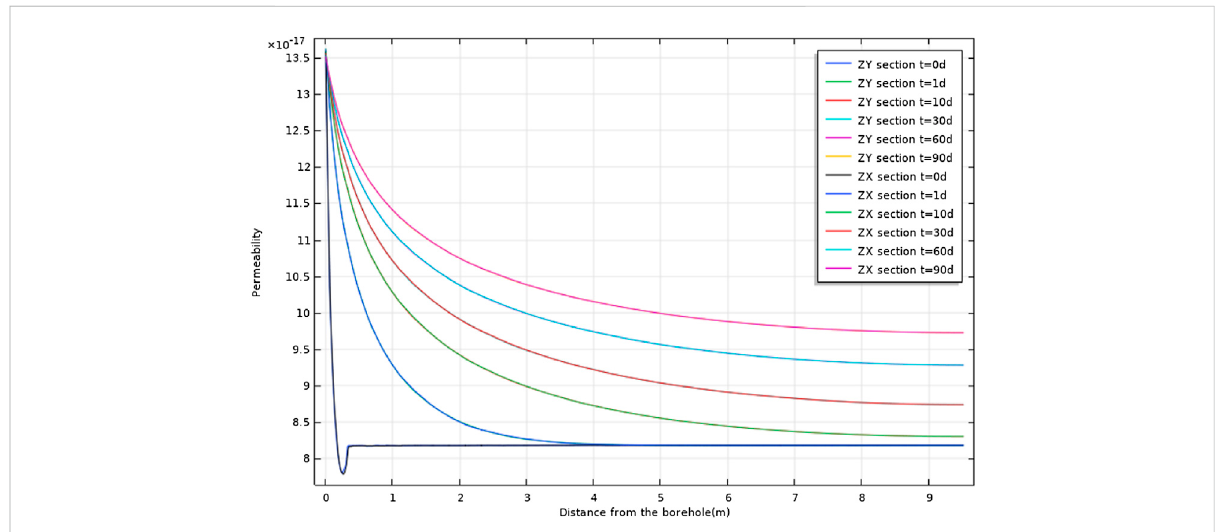
FIGURE 12 Permeability evolution of coal around cylinder hole when water content is